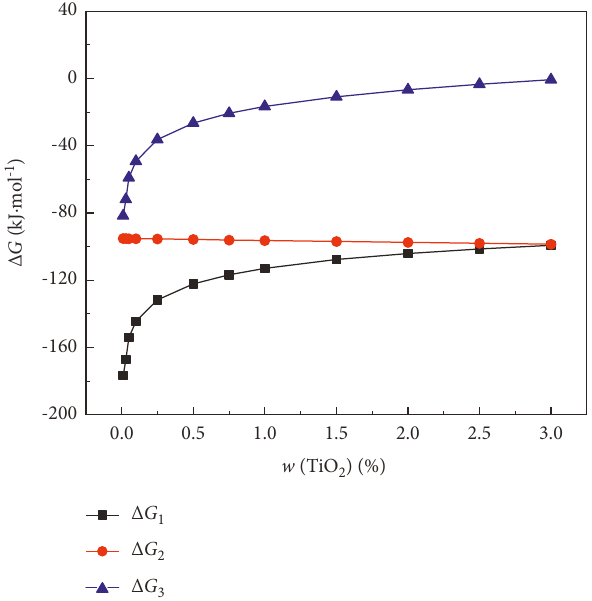
Figure 4: Gibbs free energy of the slag-steel interface chemical reaction with different TiO 2 contents for S0.